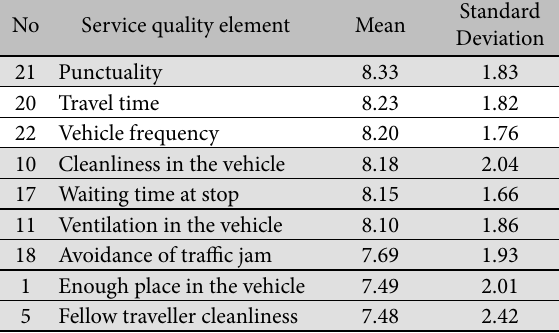
Table 3. Average preference values obtained for service quality elements